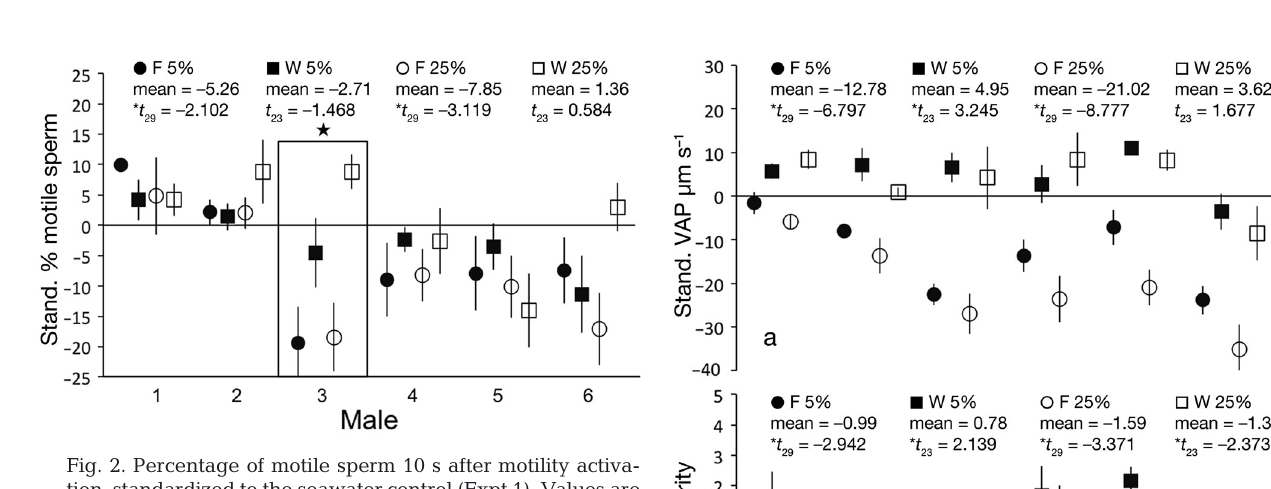
Fig. 2. Percentage of motile sperm 10 s after motility acti va - tion, standardized to the seawater control (Expt 1). Values are means (±1 SEM) of the ovarian fluids for the 5 farmed or 4 wild females. The symbols are sperm activated in the presence of the ovarian fluid of wild (squares) or farmed (circles) females. The closed and open symbols stand for 5% and 25% dilution of ovarian fluid in seawater, respectively. The significant dif- ference in the % of motile cells in wild versus farmed ovarian fluid for the third male is indicated by Q . Below each symbol legend is the mean for the 6 males and the t value of the 1-sample t -test; *results differing significantly from 0 (control)